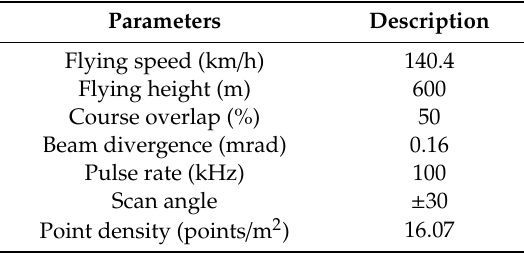
Table 2. LiDAR flight